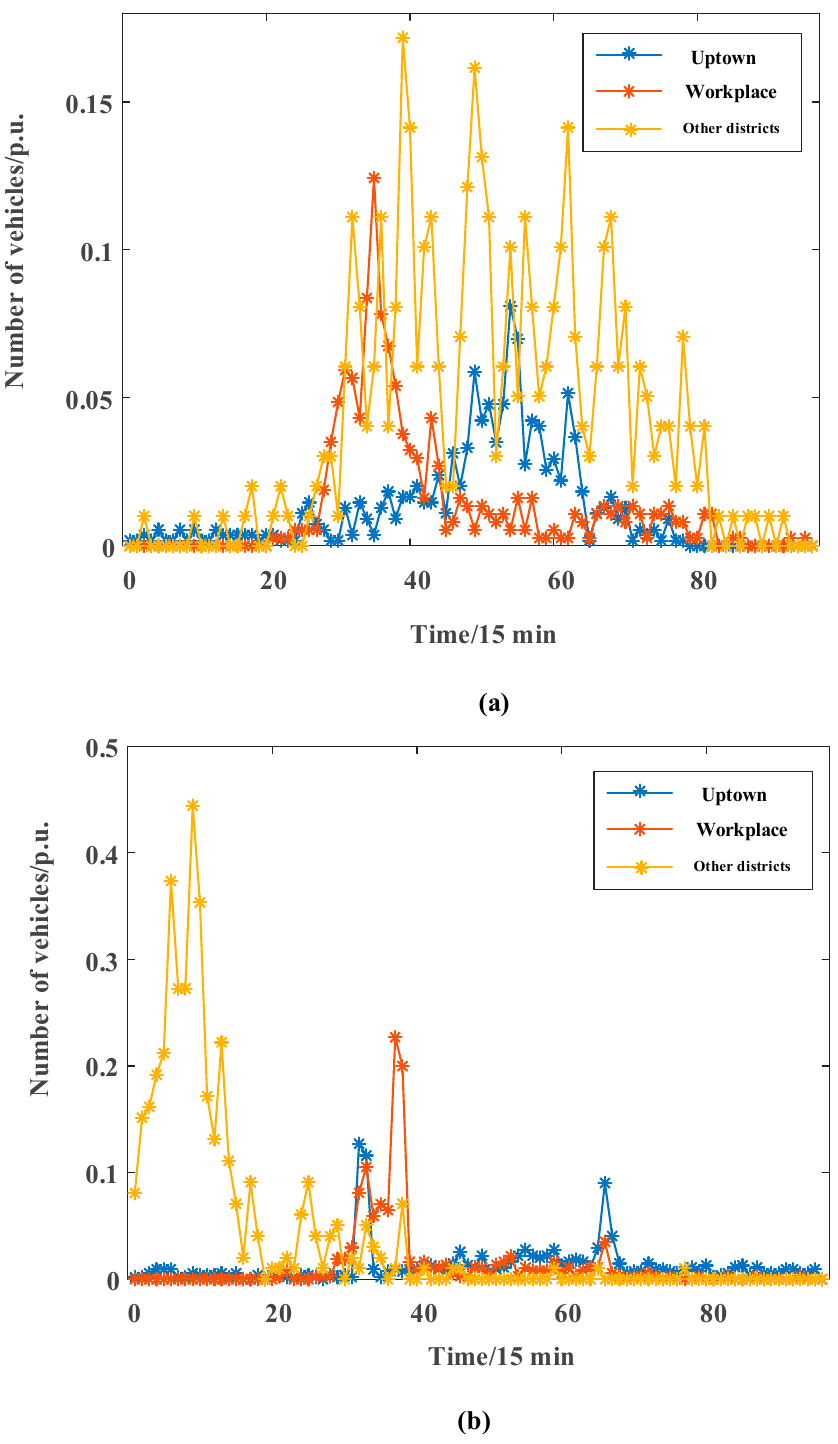
Figure 1. Distribution of the number of vehicles arriving at the parking lot and the duration of parking on a typical day: ( a ) Distribution curve of the number of vehicles arriving at the parking lot on a typical day, ( b ) Distribution curve of downtime duration for a typical day vehicle.